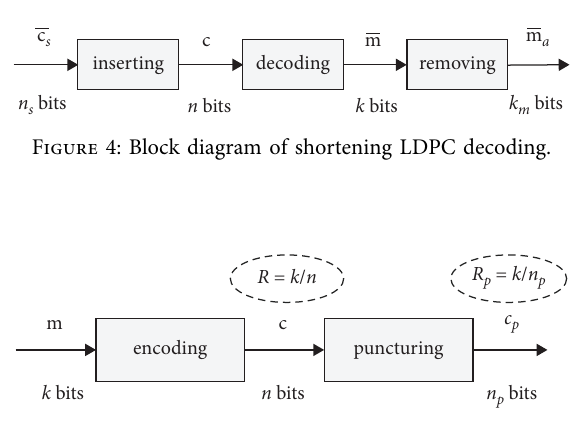
Figure 5: Block diagram of puncturing LDPC encoding.